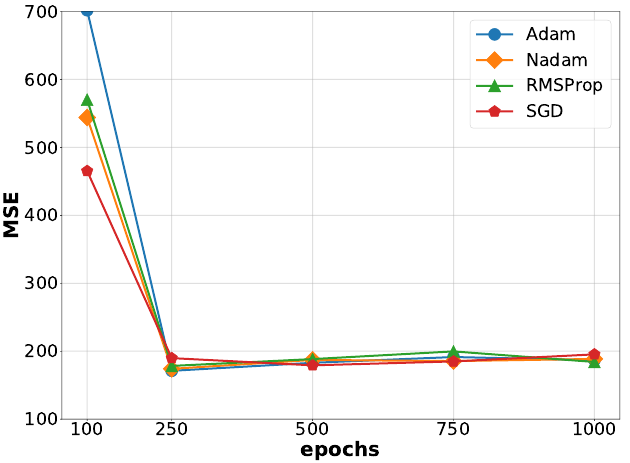
Figure 12. MSE performance of 4-layer ANN model with different gradient descent algorithms and